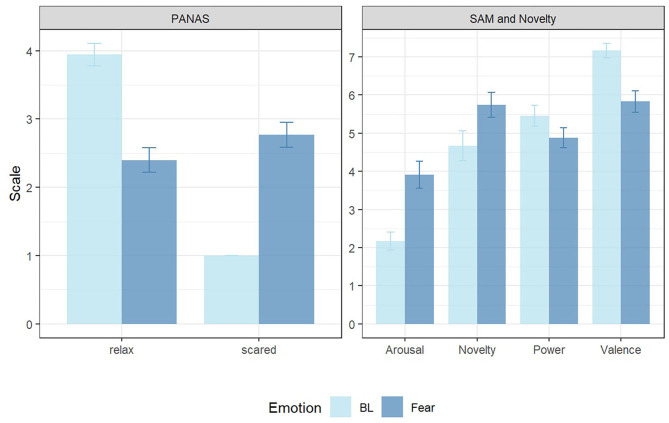
Mean and standard error of ratings in PANAS “relax” and “scared” (left) as well as in SAM scales and the added dimension of novelty (right) in Baseline (BL, light blue) and Fear (dark blue).